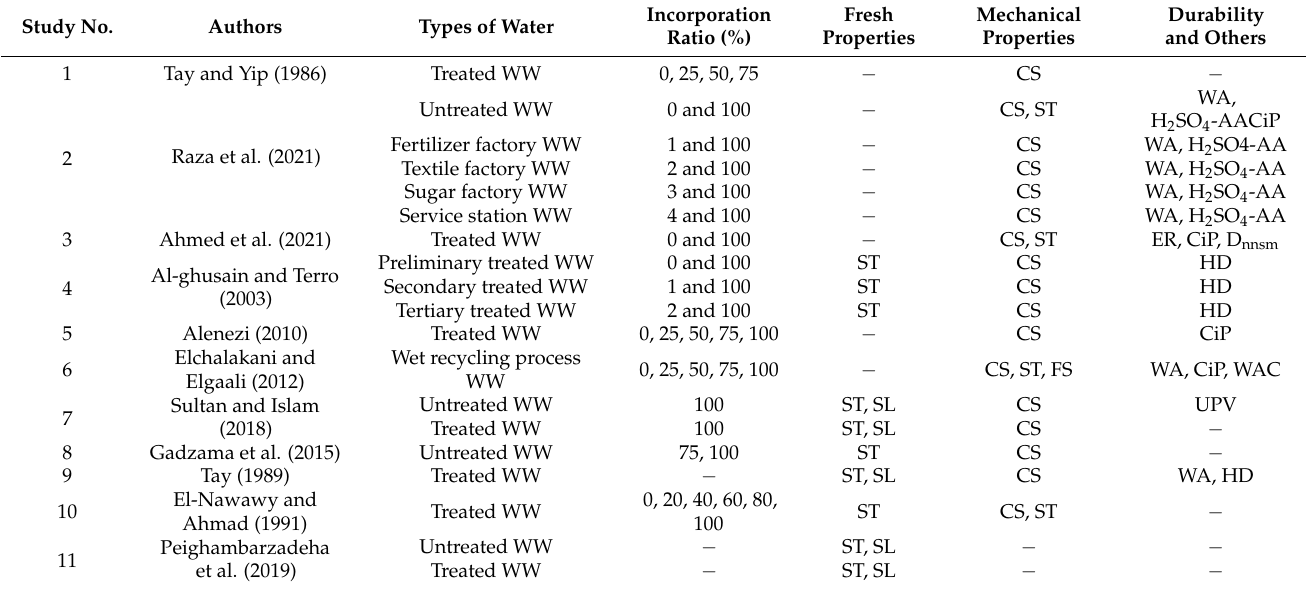
Table 1. Tests and type of WW used in concrete based on the selected